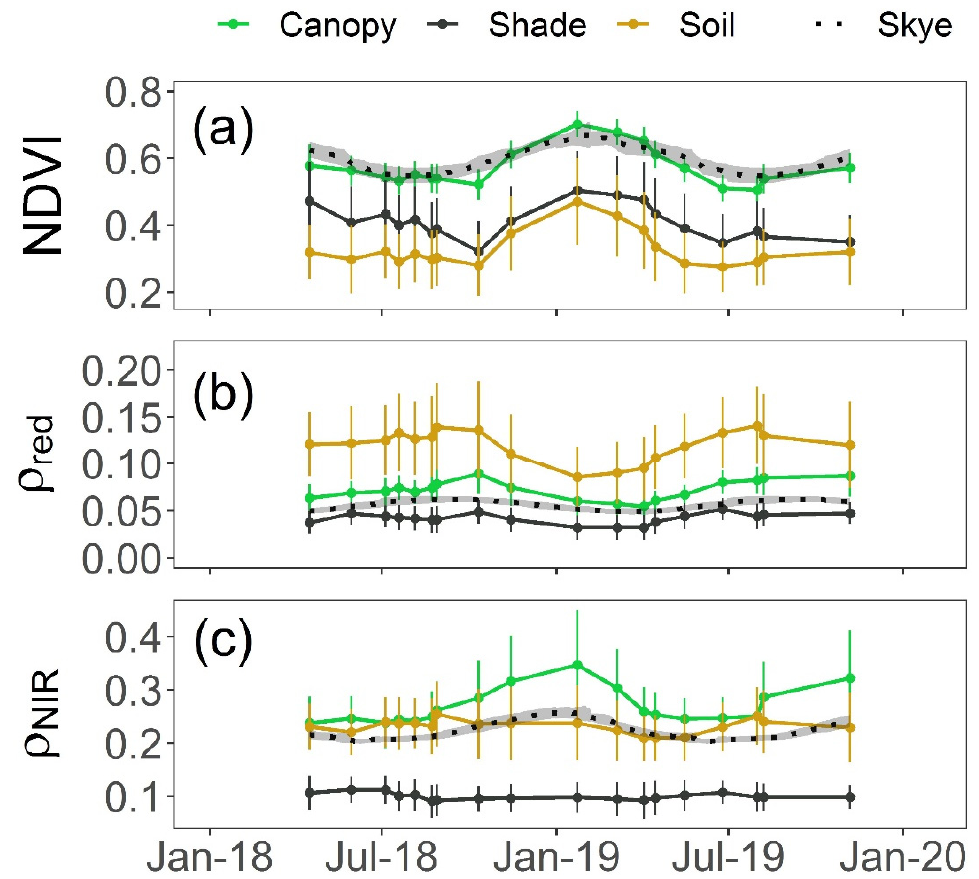
Figure 5. The UAV-measured ( a ) NDVI, ( b ) red reflectance, and ( c ) NIR reflectance for pure canopy (in green), bare soil (in brown), and shade (in black) from April 2018 to May 2019. The dots are the mean values over the Landsat 8 tower pixels for each UAV flight, with the error bars indicating the standard deviations in the pixel area. The dotted line represents the mean seasonal variations of the Skye data in 2013–2018 based on a 90-day moving average of the raw measurements. The grey area presents the standard deviations of the multi-year seasonal variations.